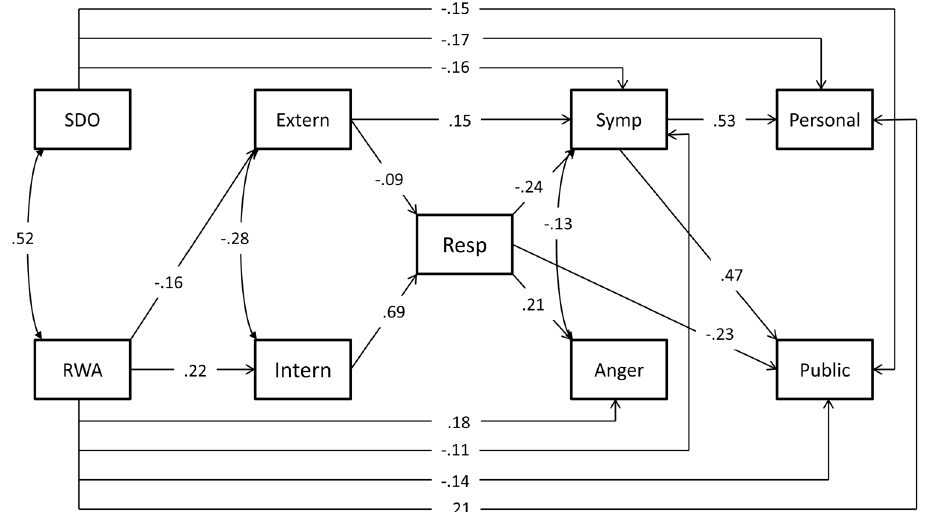
Figure 1. Model predicting motivation to personally help and approval of public spending for treatment of the addicted. SDO = Social Dominance Orientation Scale; RWA = Right-Wing Authoritarianism Scale; Extern = Attributions to external cause; Intern = Attributions to internal cause; Resp = Responsibility; Symp = Sympathy; Personal = Motivation to personally help; Public = Approval of public spending on